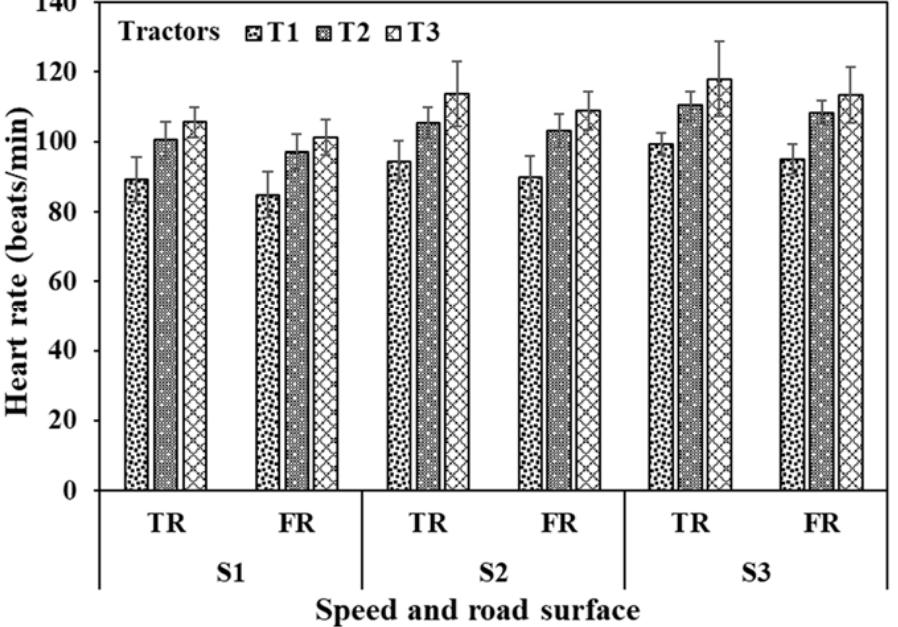
Figure 6. Heart rate of the operators during tractor clutch and brake operation. TR—Tarmacadam